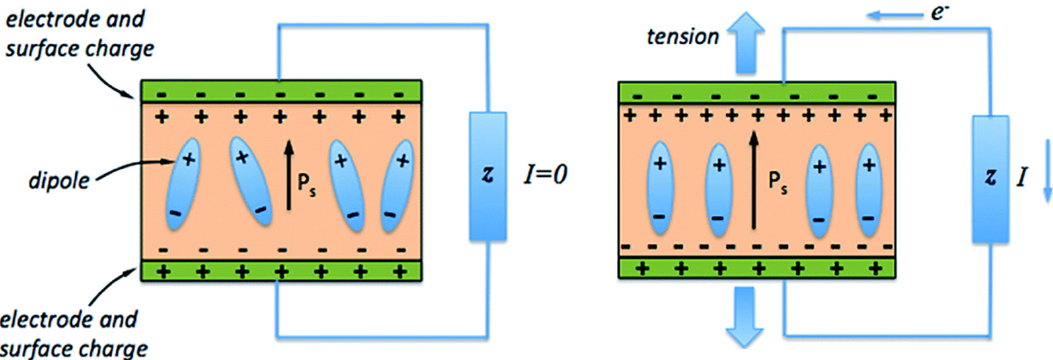
Figure 2. Electro actuation mechanism of a piezoelectric polymer actuator [11]. Open access, Copyright Royal Society of Chemistry.